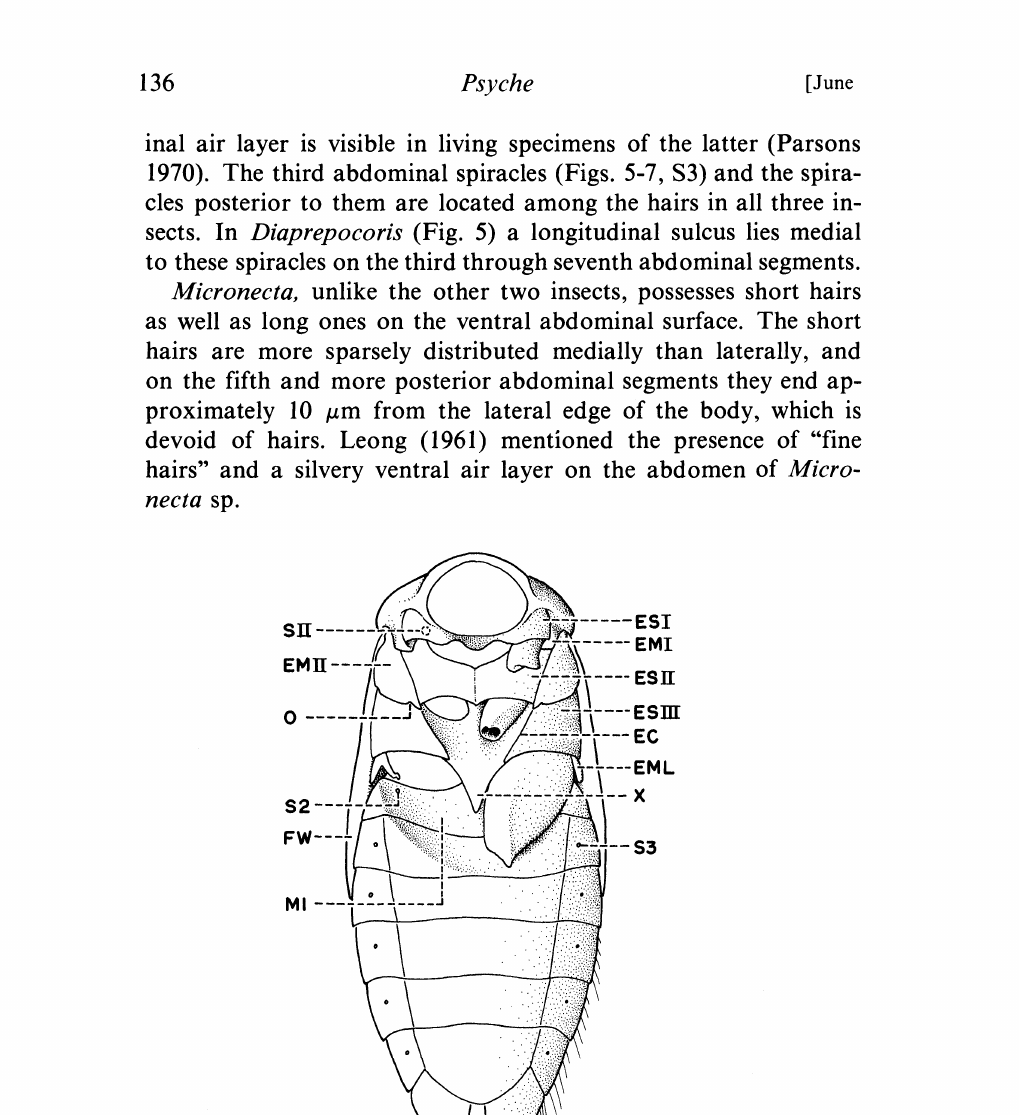
Fig. 5. D. zealandiae, ventral view. Head and legs removed; coxae and long setae shown only on right side of figure. Mesothoracic spiracle (S II) concealed by